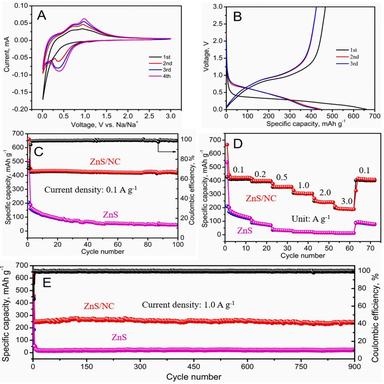
Electrochemical performance in SIBs: (A) CV curves from 0.01 to 3 V at a scan rate of 0.1 mV s−1 and (B) Discharge/charge profiles for initial three cycles; (C) Cycling, (D) Rate and (E) Long-term cycling performance of ZnS/NC composite and ZnS at 1.0 A g−1.